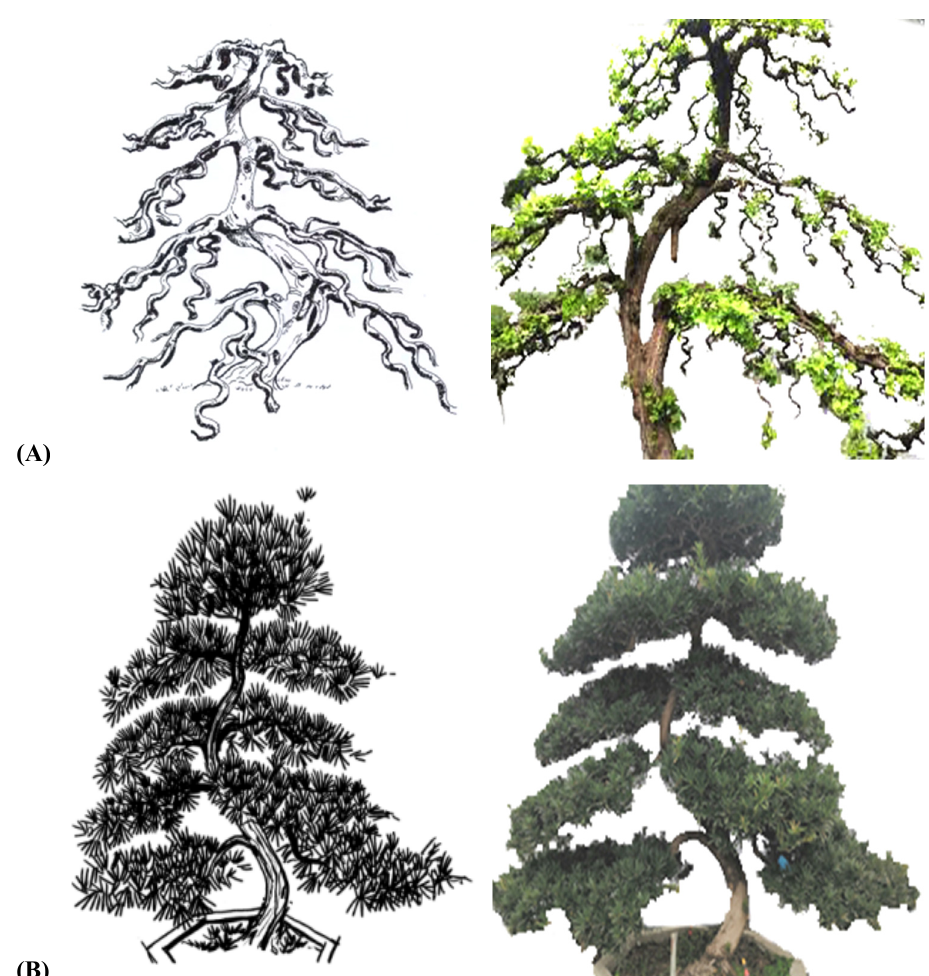
Figure 5. Comparison of the standard ( A ) and nonstandard ( B ) flat-branch styles.